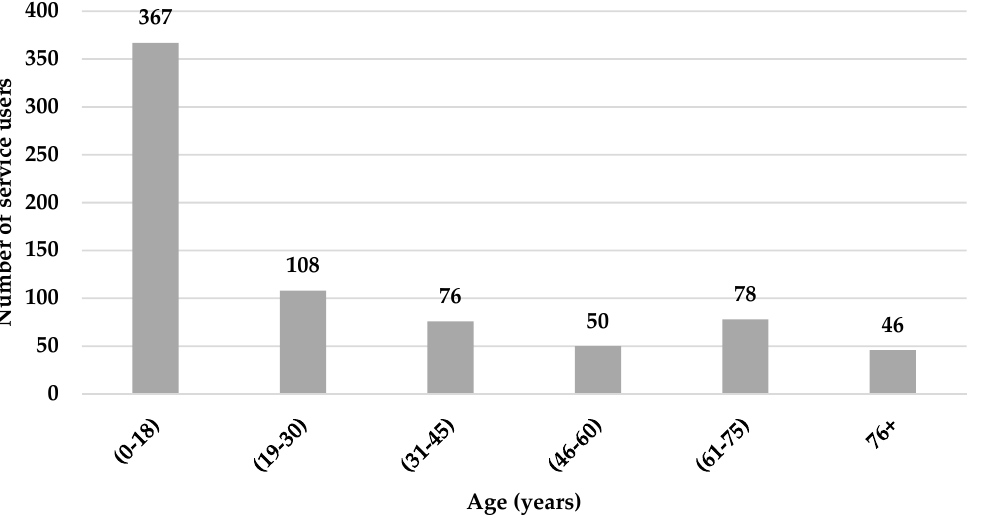
Figure 1. Age distribution of service users.